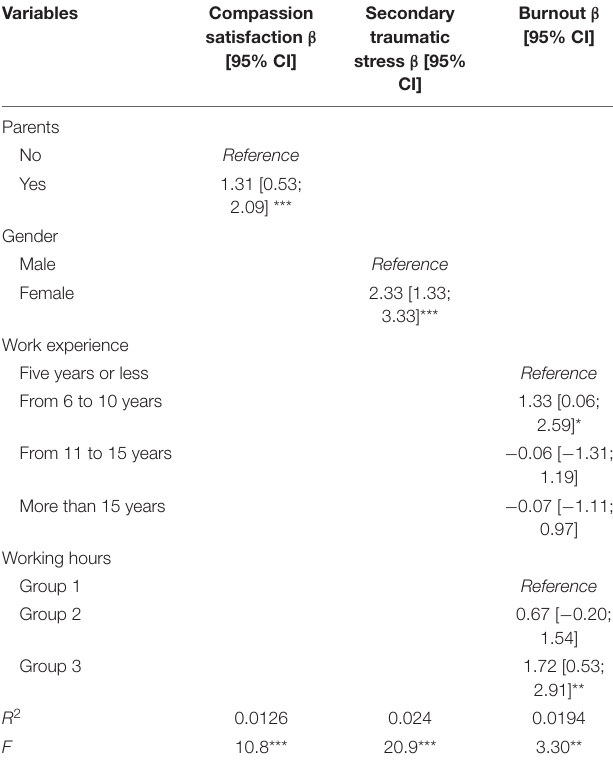
TABLE 3 | Regression coefficients for professional quality of life subscales as outcomes and socio-demographic, and professional variables as predictors from univariate simple and multiple linear